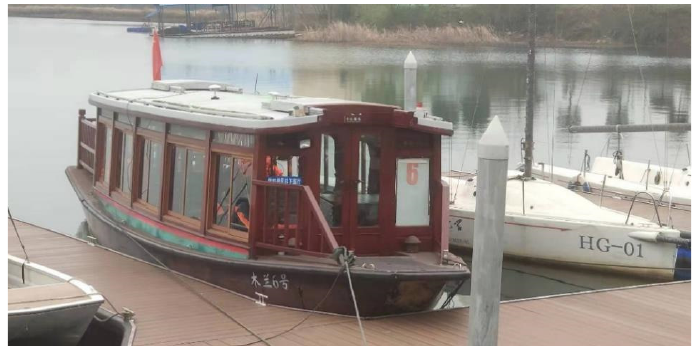
Figure 20. Experimental vessel.